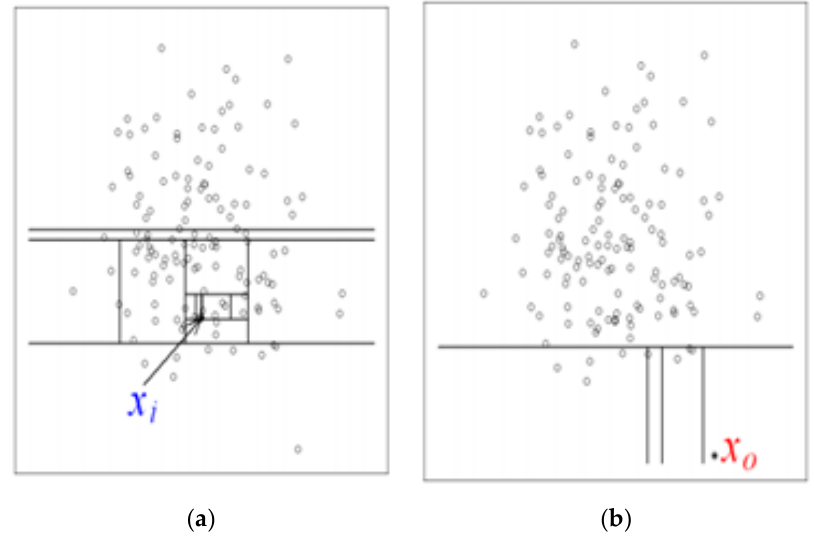
Figure 4. Examples of normal vs. abnormal data: ( a ) indicates how X_i needs more splits and trees to reach the data. ( b ) indicates how X_o, an anomaly, needs much less trees.